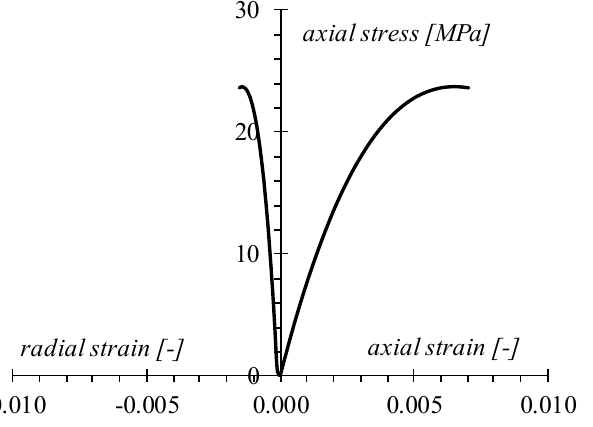
Figure 2. U-series stress–strain behavior (curve was averaged from five specimens).